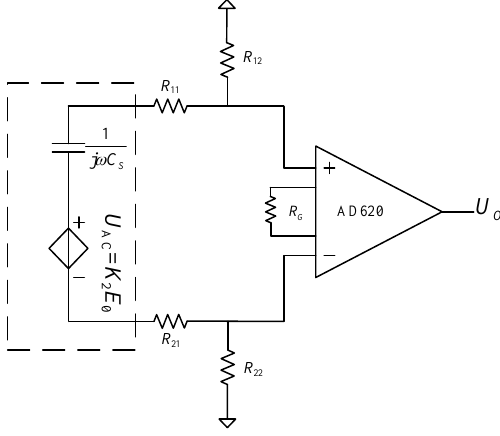
Figure 4. Equivalent circuit of the signal extraction module.